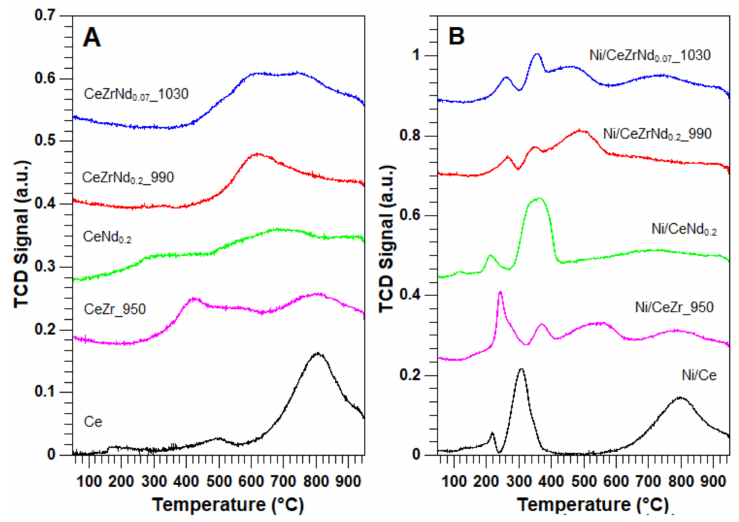
Figure 6. TPR profiles of ( A ) supports and of ( B ) Ni-supported